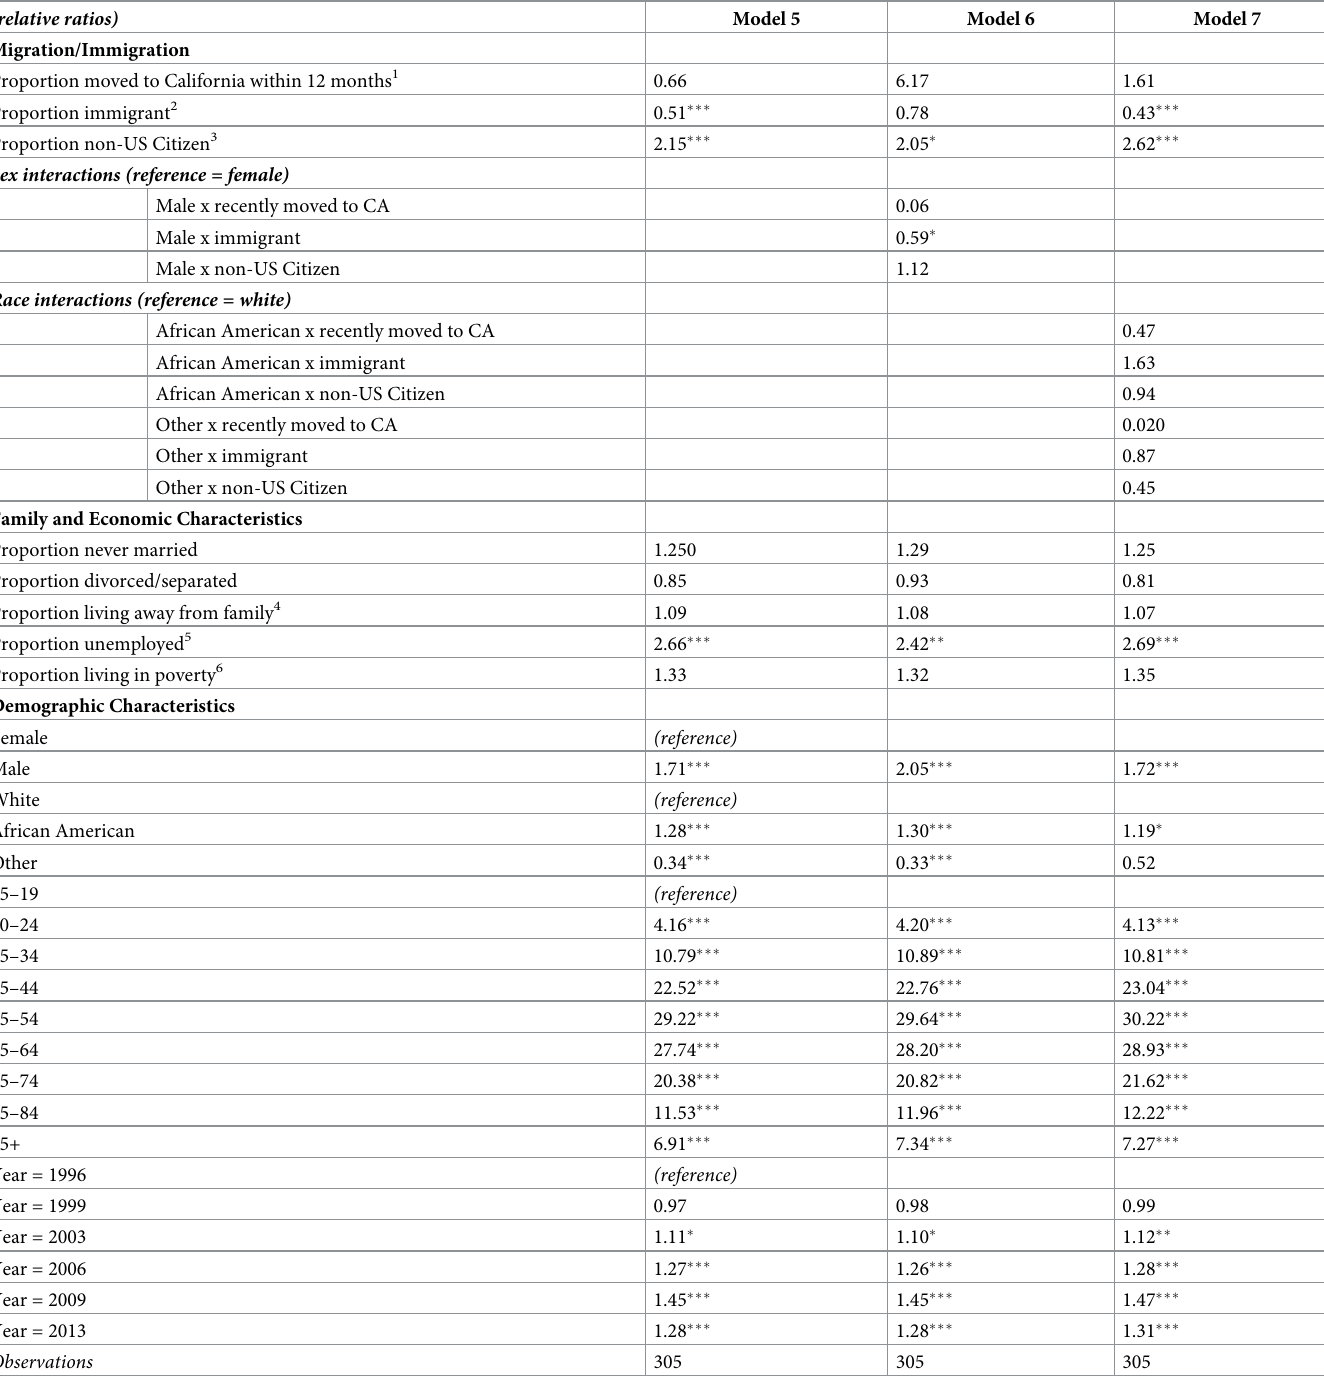
Table 4. Poisson estimation of relative rates of bodies being unclaimed by migration histories and immigration characteristics